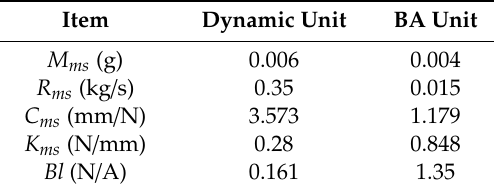
Table 1. Parameters of the dynamic speaker